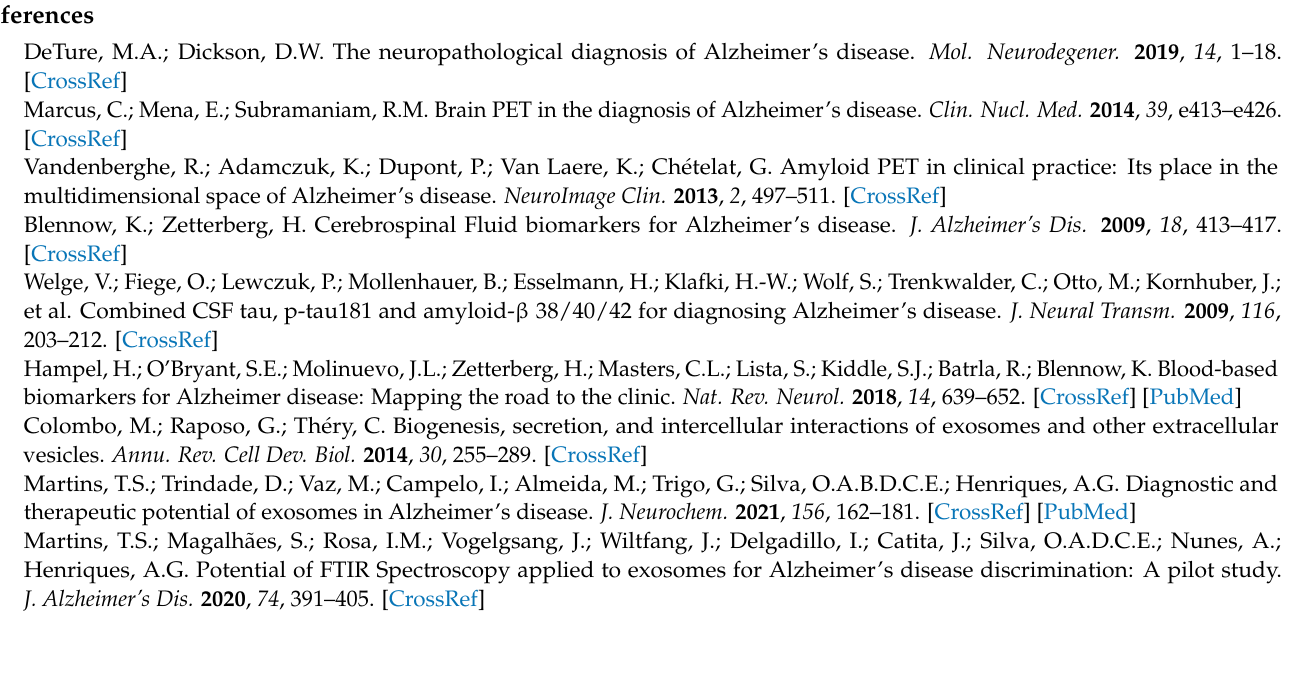
participants; Table S3: Demographics and clinical data of UMG-group participants, Table S4: List of proteins found in exosomes isolated from CSF, serum and plasma and previously related to Alzheimer’s disease; Table S5: Final CSF proteome list; Table S6: Final serum proteome list; Table S7: Final plasma proteome